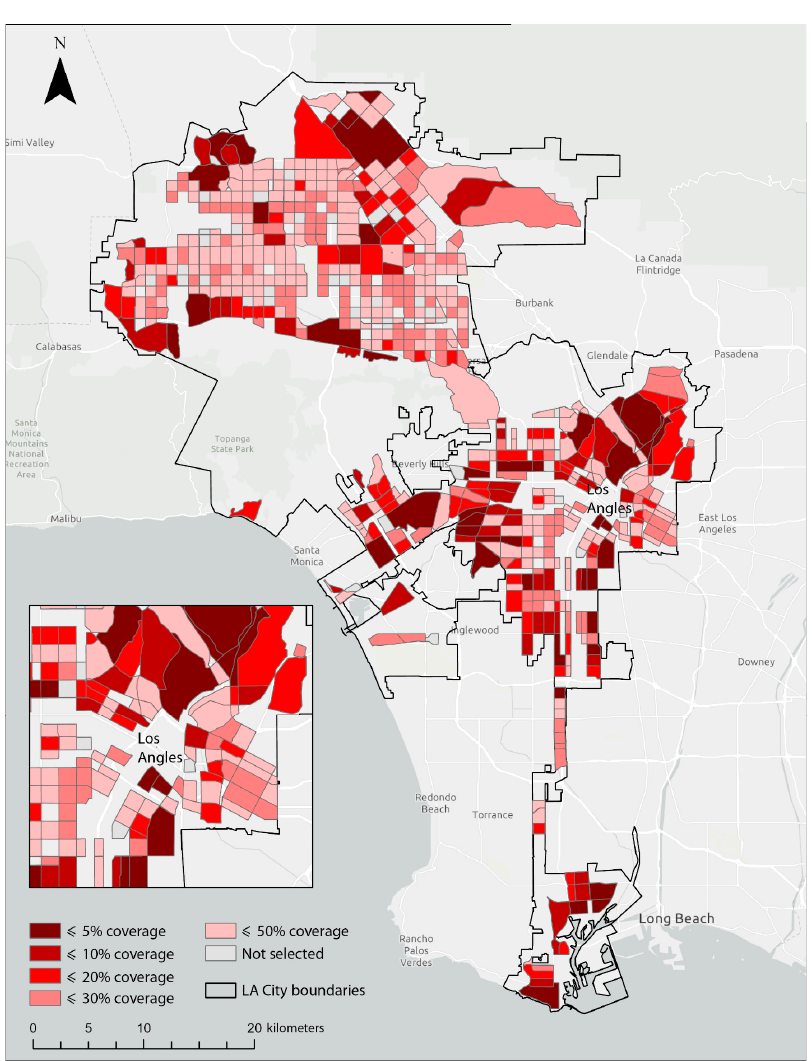
Figure 2. Superblocks included in each of the five transformation scenarios.